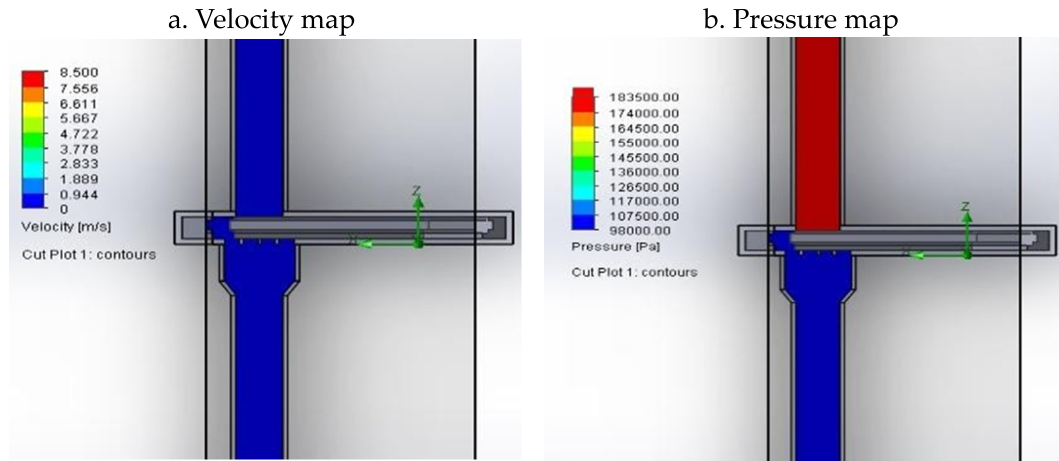
Figure 7. First valve geometry. ( a ) Front view; ( b ) side view.